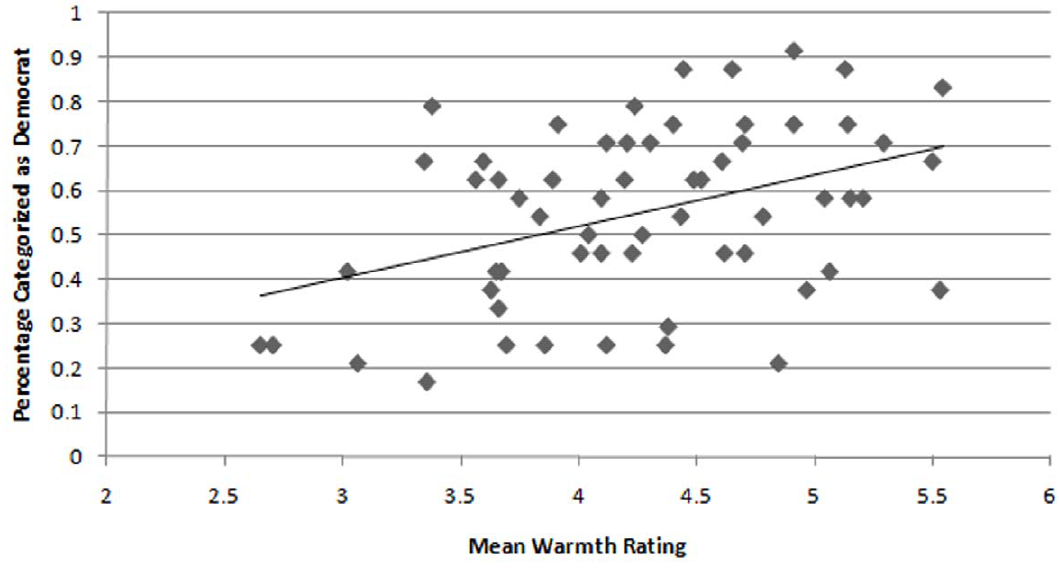
Figure 4. Relationship between the likelihood with which a target was perceived to be a Democrat in Study 2 and the mean Warmth rating for that target based on naı¨ve judges’ perceptions in Study